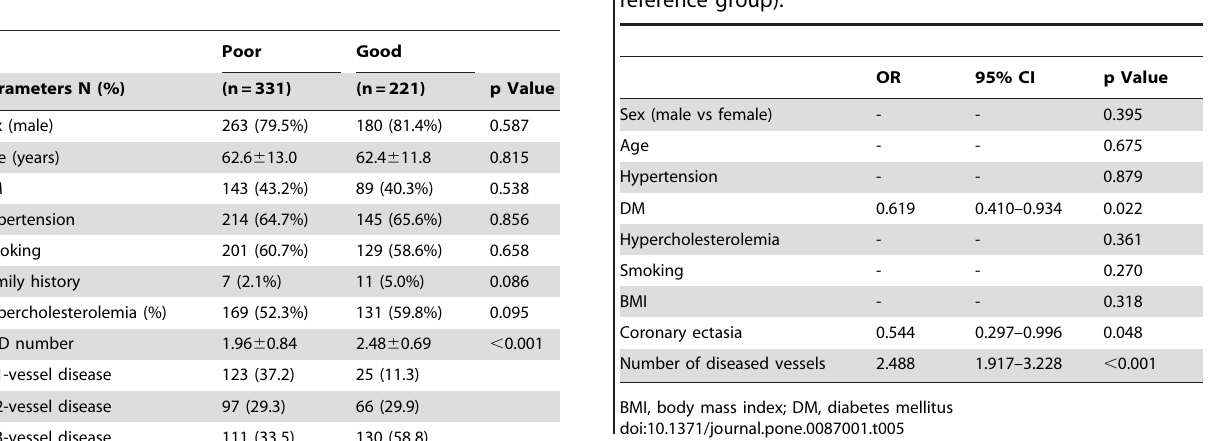
Table 4. Baseline Characteristics between good and poor collaterals.